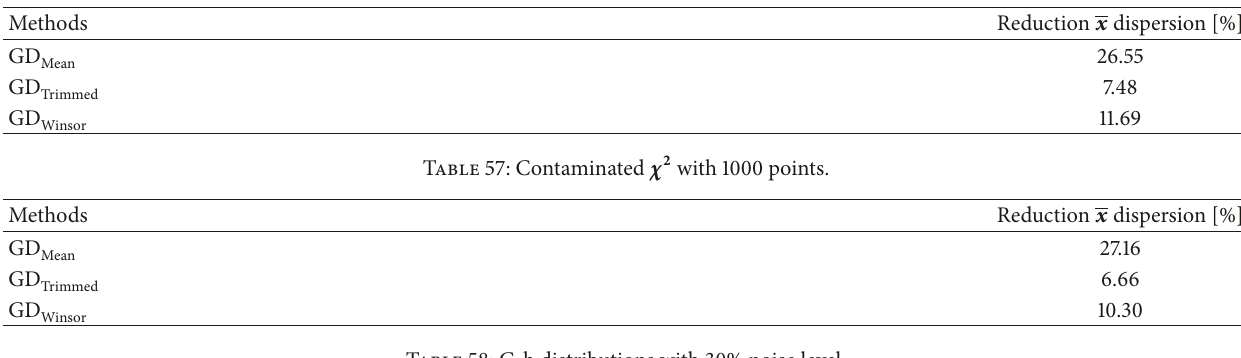
Table 58: G-h distributions with 30% noise level.